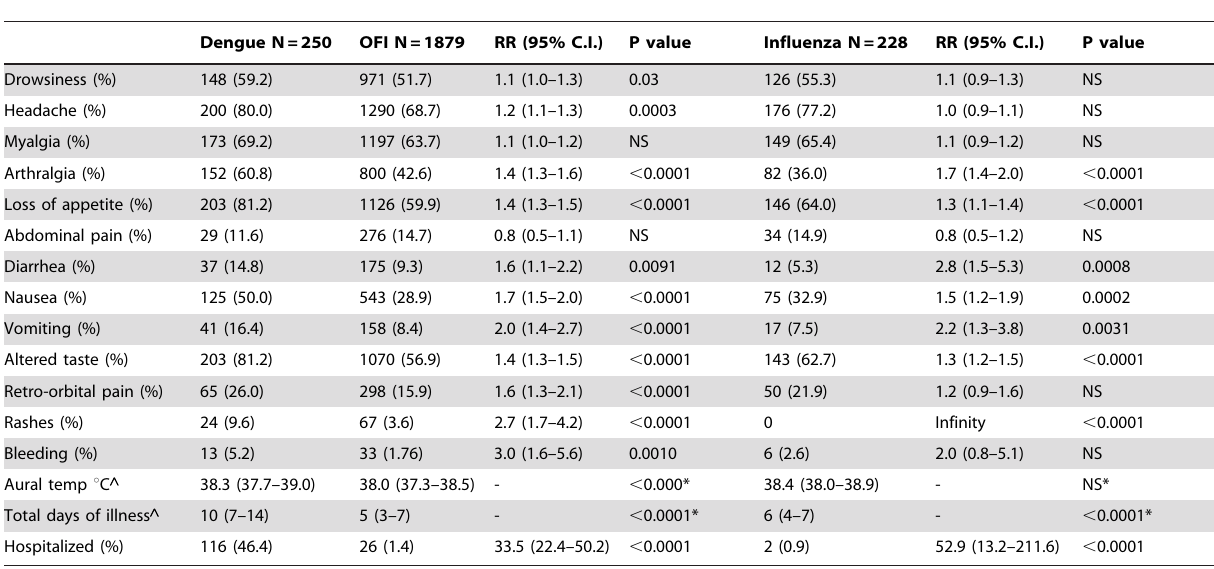
Table 3. The early clinical features and outcomes of dengue, OFI and influenza.